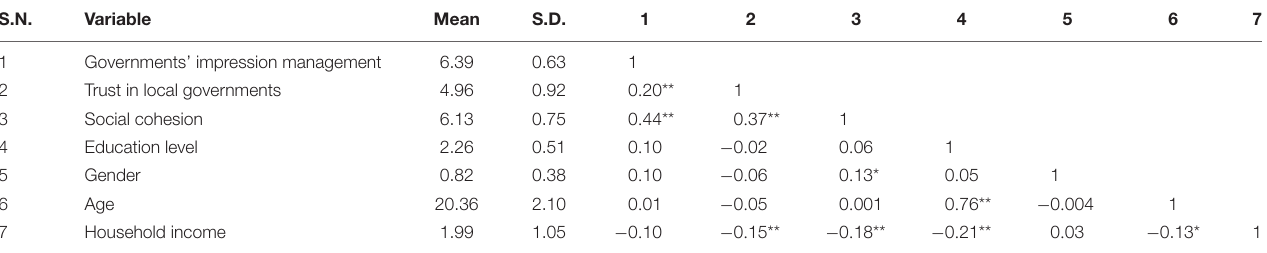
TABLE 1 | Means, standard deviations, and pearson correlation coefficients of all variables.